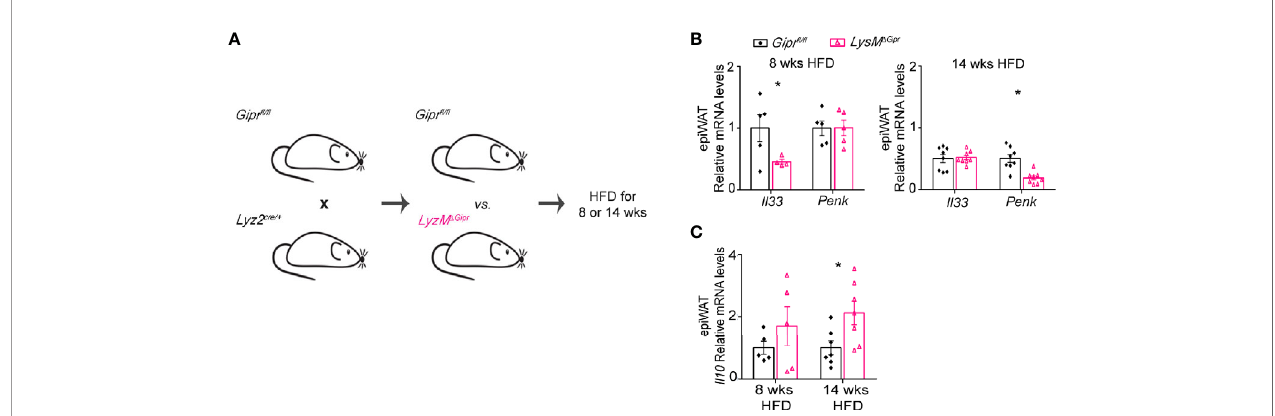
FIGURE 4 | De fi ciency of GIP signaling in myeloid immune cells drives the impairment of type 2 immune networks in the obese epiWAT. (A) Scheme illustrating experimental design. Mice with targeted GIPR-de fi ciency to myeloid cells ( LysM D Gipr , pink open triangles) and their littermate controls ( Gipr fl / fl , black rhombus) were fed a HFD for 8 and 14 weeks (n ≥ 6). (B) qRT-PCR assessment of the expression of Il33 and Penk genes in epiWAT normalized to Rplp0 . (C) qRT-PCR assessment of the expression of Il10 in epiWAT of LysM D Gipr and Gipr fl / fl mice after shorter (8 weeks) and longer (14 weeks) HFD-regimes. Data are analyzed by unpaired, two- tailed t -test and presented as mean ± SEM. *p ≤ 0.05.